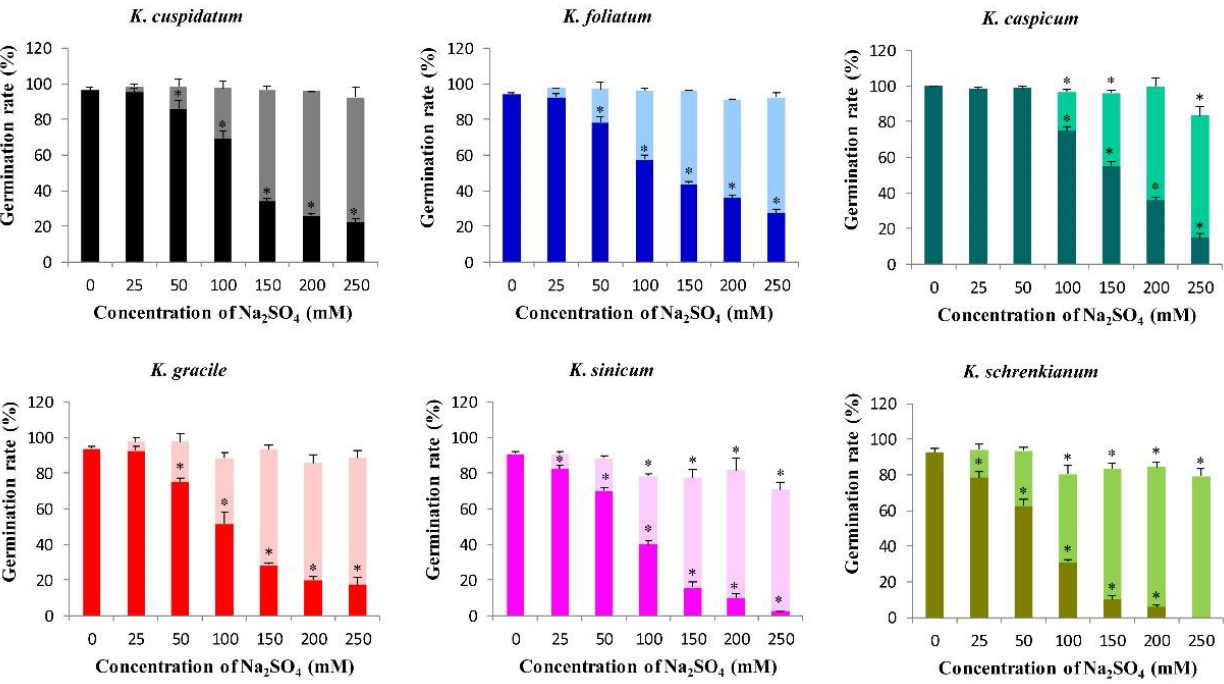
Figure 7. Total germination percentages after 14 days at the indicated Na 2 SO 4 concentrations in the six studied Kalidium species. Germination rates (%, means and standard deviations) of the six Kalidium species after treatments with indicated concentrations of Na 2 SO 4 (0, 25, 50, 100, 150, 200, and 250 mM) after 7 days. The dark bars indicate germination rates after the treatments and light bars the total percentages that germinated during the recovery treatment in distilled water with additional 7 days. Asterisks indicate significant differences in each condition respect to the corresponding control (according to Dunnet test, p < 0.05).